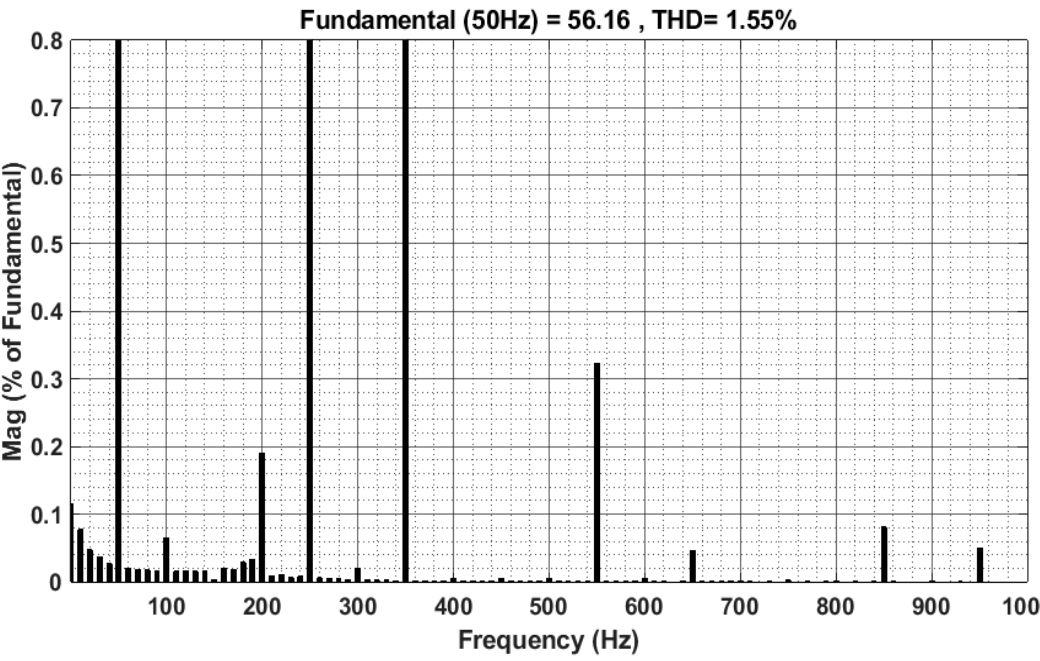
Figure 12. Total harmonic distortion (THD) result of the input current of Phase A.